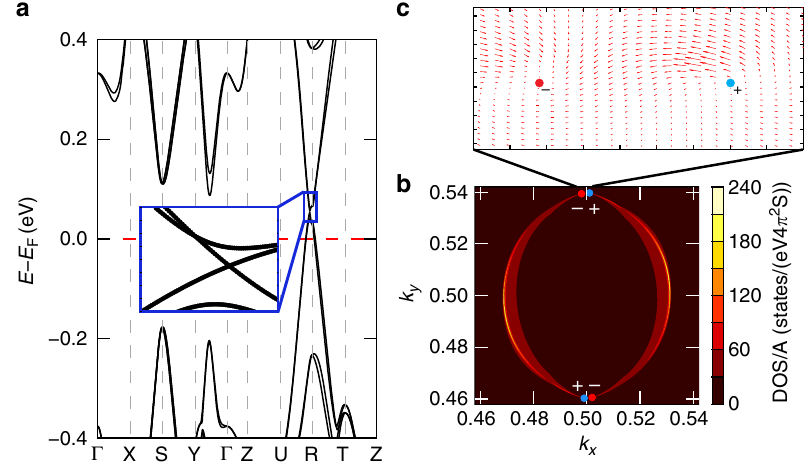
Fig. 4 Weyl semimetal phase of Ag 2 BiO 3 . a Electronic band structure. b The corresponding Fermi surface (0.08 eV above the Fermi level) on the (001) surface. The fi lled circles indicate the projected Weyl points on the surface for two pairs of Weyl points with opposite chirality (+ and − ). c Two dimensional plot of the Berry curvature showing the opposite chirality of one pair of Weyl nodes. A 3D plot is given in Supplementary Figure 4